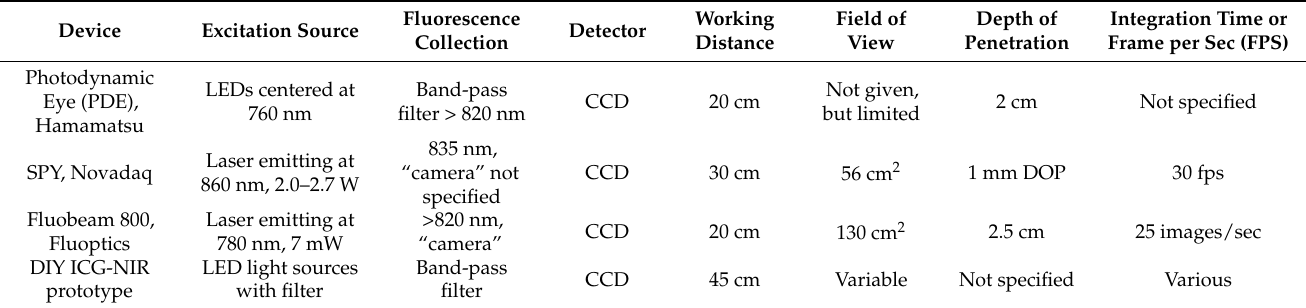
Table 4. Comparison of ICG-NIR devices.